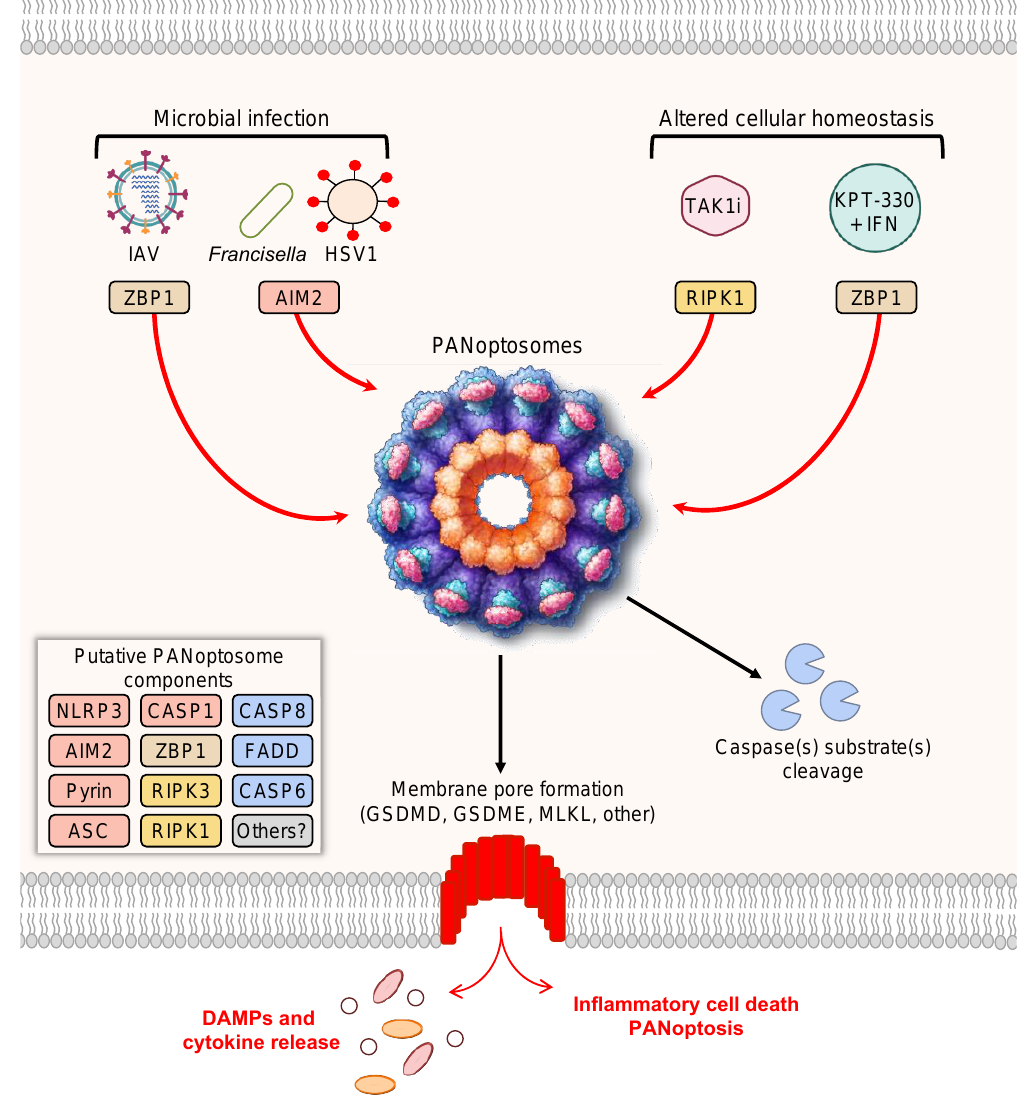
Figure 1. PANoptosis and PANoptosome formation. Upon exposure to cellular insults, such as microbial infection or altered cellular homeostasis, sensors can detect the perturbation and activate PANoptosis. Prototypical examples of PANoptosis are depicted here. Sensor activation can lead to the formation of a multiprotein complex, the PANoptosome. PANoptosomes have the potential to bring together diverse components from previously segregated cell death pathways. These may be dynamic complexes, and their protein composition may vary in trigger- and time-dependent manners. Potential PANoptosome components putatively include inflammasome sensors, such as nucleotide-binding oligomerization domain-like receptor family pyrin domain-containing 3 (NLRP3), absent in melanoma 2 (AIM2), Pyrin, Z-DNA-binding protein 1 (ZBP1), or others; apoptosis-associated speck-like protein containing a caspase activation and recruitment domain (ASC); caspase-1 (CASP1); receptor-interacting serine/threonine protein kinase 3 (RIPK3); RIPK1; caspase-8 (CASP8); Fas-associated protein with death domain (FADD); and/or caspase-6 (CASP6). PANoptosis involves membrane pore formation for the execution of cell death to release cytokines, such as IL-1 β and IL-18, and DAMPs. Figure created with BioRender.com (accessed on 17 March 2022).